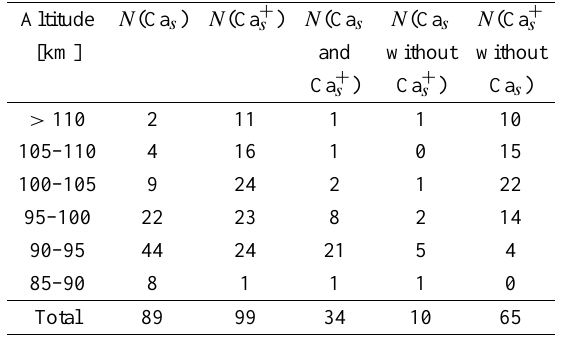
Table 1. Altitude distribution of Ca s and Ca + s . The total numbers N per bin (columns 2 and 3) are summarized for all observations of this species, the numbers in columns 4 to 6 only for nights